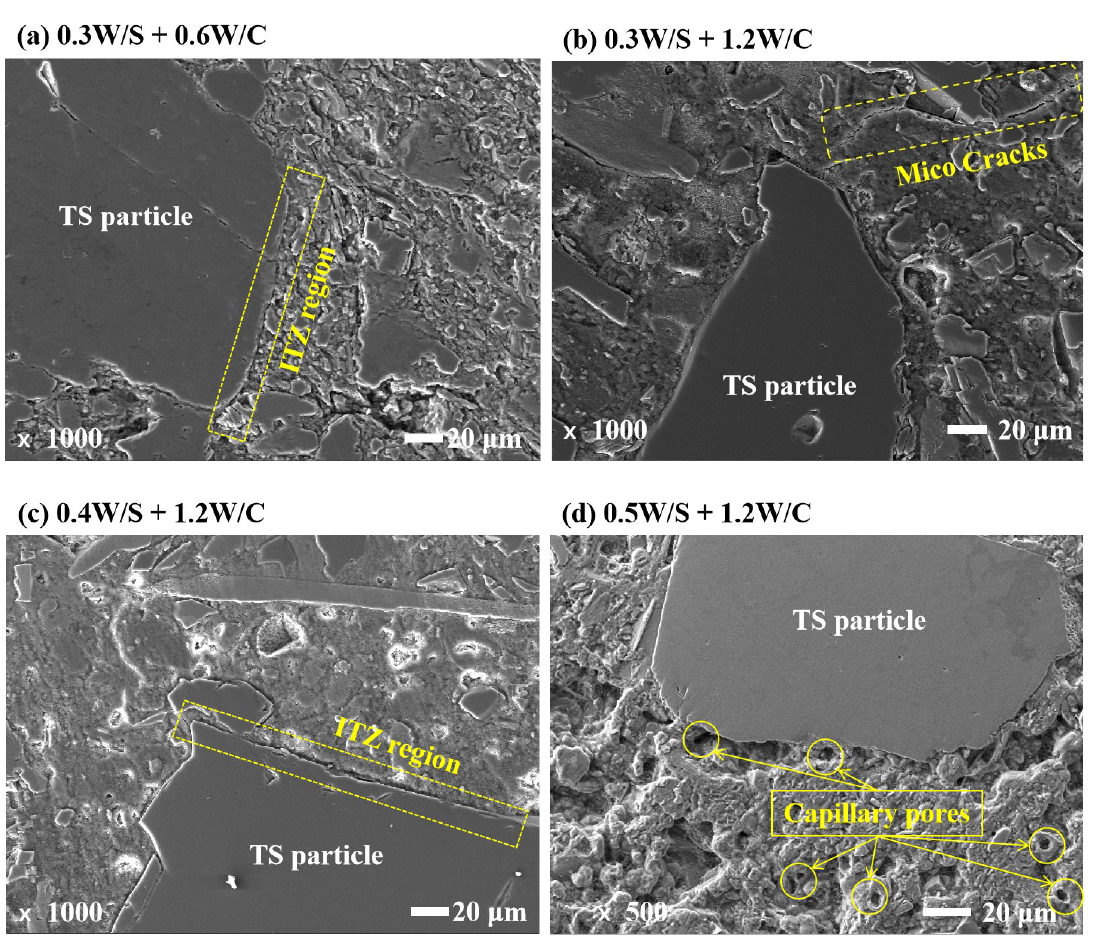
Figure 8. Representative SEM-BSE image of CPB specimens at 28